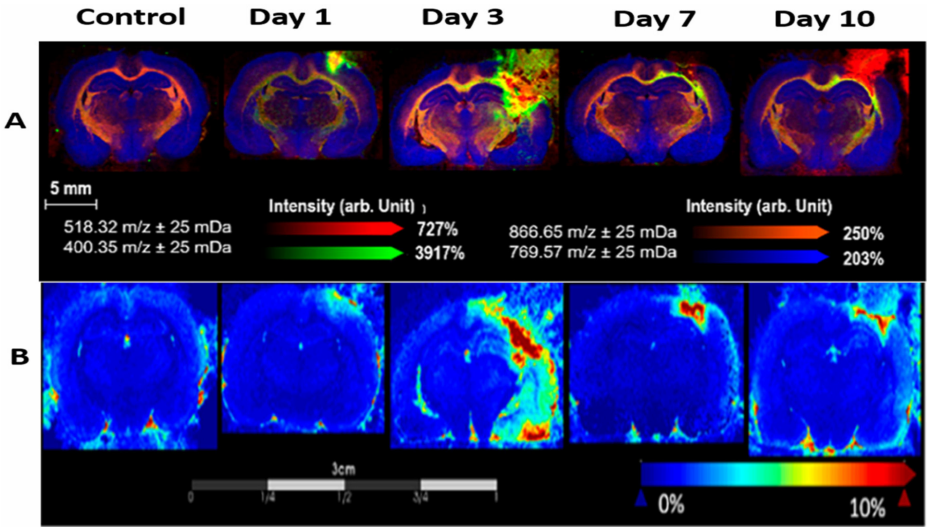
Figure 6. The post-TBI altered lipidomic profile revealed by MALDI-MSI shows the expression of ( A ) palmitoylcarnilite and ( B ) lyso-phosphatidylcholine in caudal sections of brain at different time points after brain injury. This figure was adopted and modified from Mallah et al.